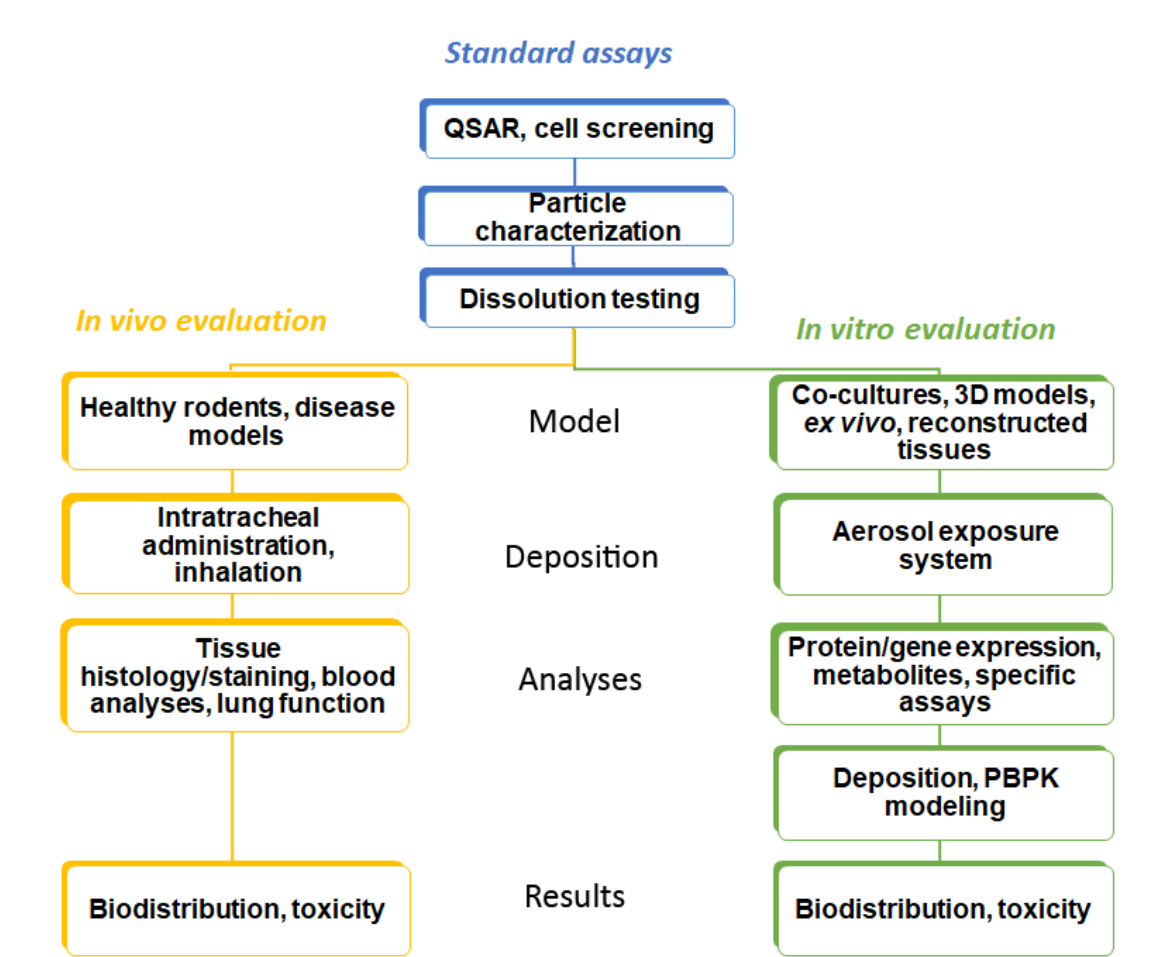
Figure 1. Workflow in the testing of inhaled substances. Common techniques in the testing are shown in blue, in vivo testing methods in yellow, and alternative testing methods (in silico and cellular models) in green boxes.